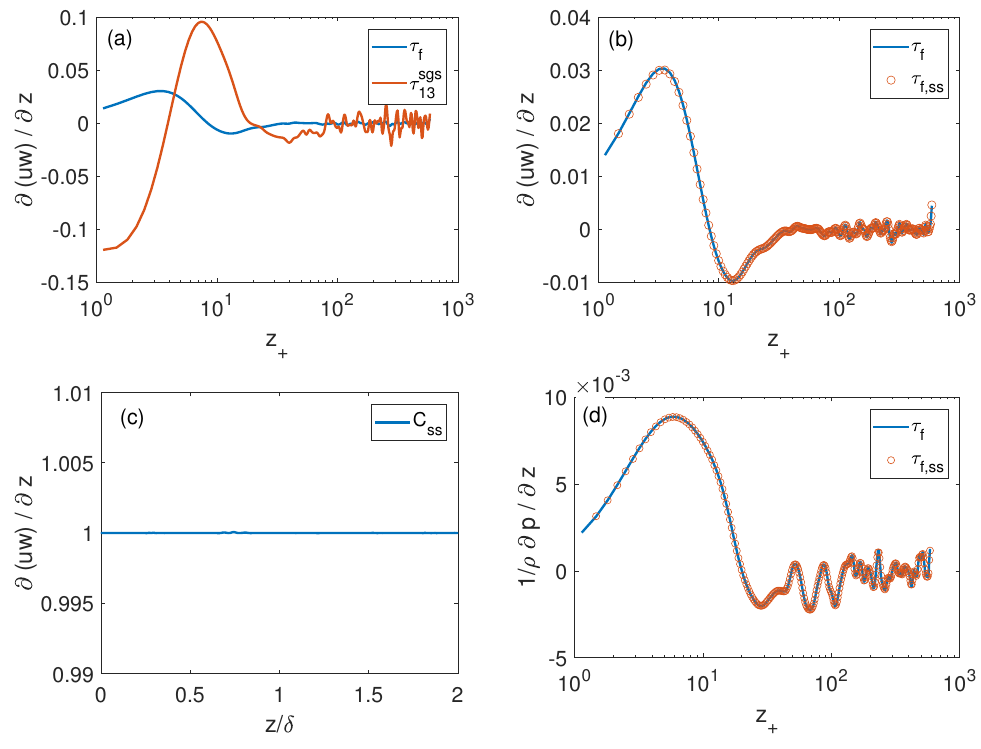
Figure 5. ( a ) Commutation error at primary filter level f for the first derivative ∂ uw / ∂ z compared to the SGS component ∂ ( uw − u w ) / ∂ z ( b ) Commutation error at primary filter level f for the first derivative ∂ uw / ∂ z together with the corresponding scale similarity model. ( c ) Dynamic model parameter C ss averaged in both homogeneous directions. ( d ) Commutation error at primary filter level f for the pressure gradient ∂ p / ∂ z together with the corresponding scale similarity model.